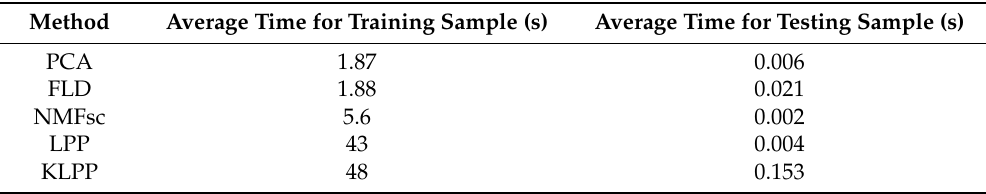
Figure 8. Probability distribution of different methods: ( a ) PCA; ( b ) FLD; ( c ) NMF; ( d ) NMFsc. Table 4. Dimension reduction time of different